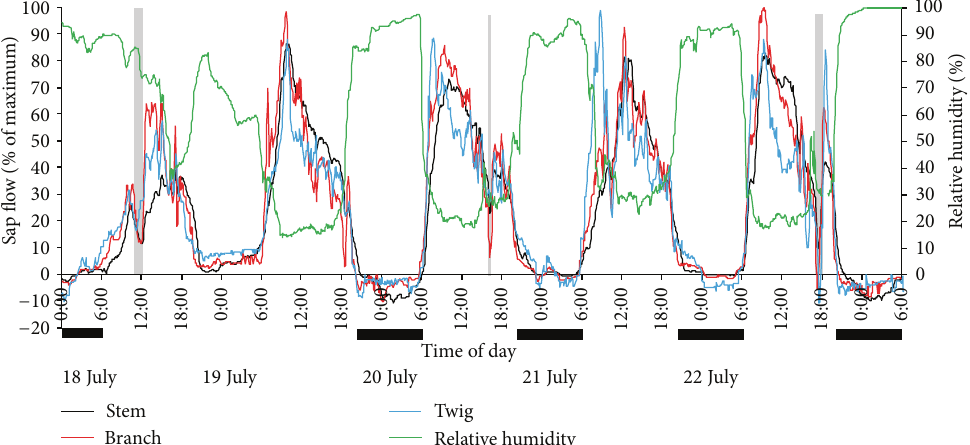
Figure 2: Five days of sap flow at the three different positions on the T. ramosissima plant under different air humidity conditions. Black bars represent that plant was exposed to high atmospheric humidity caused by the humidifier. Light gray bars represent precipitation events and the detailed information was provided in Table